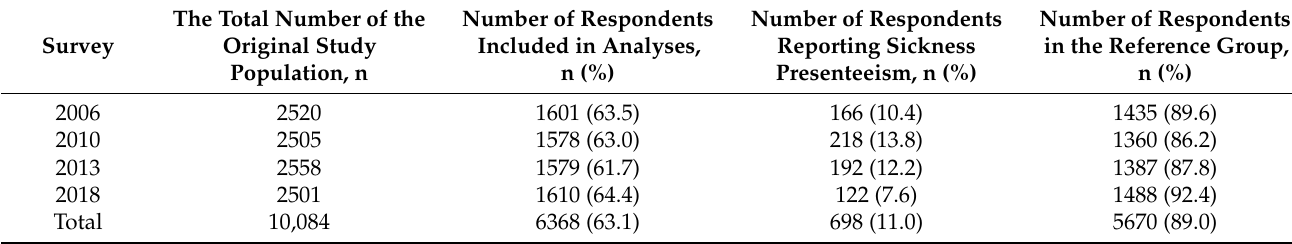
Table 1. Descriptive data for the study